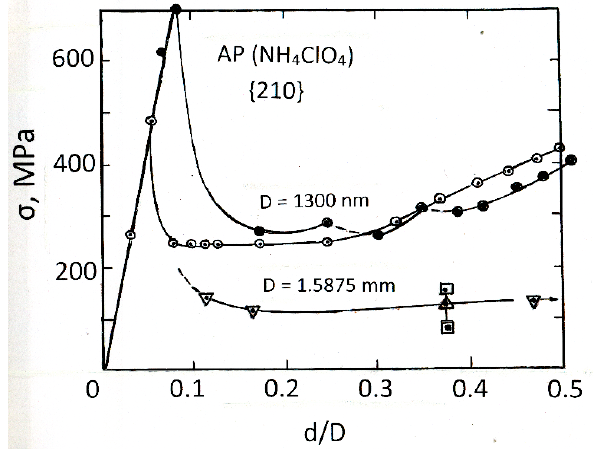
Figure 2. Elastic–plastic stress–strain calculations for two nano-indents in AP [6], also in comparison with other (open square and triangle) diamond pyramid micro-hardness [7,8] and (inverted